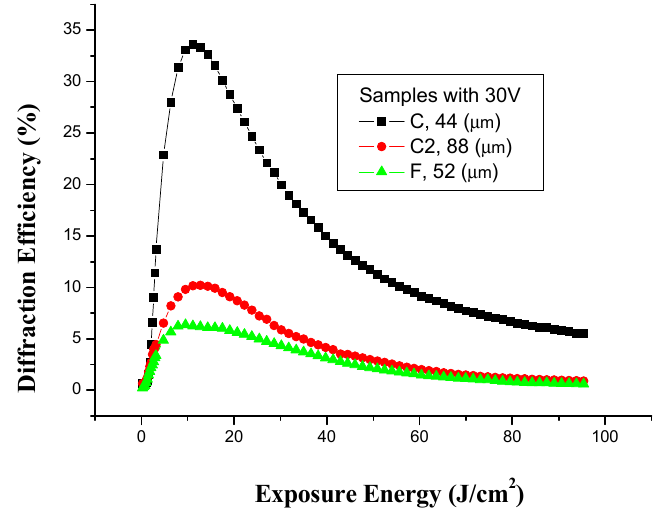
Figure 10. First-order diffraction intensity vs exposure time with applied voltage of 30 V for grating with 454 lines/mm, made from sample C, C2, and F with different